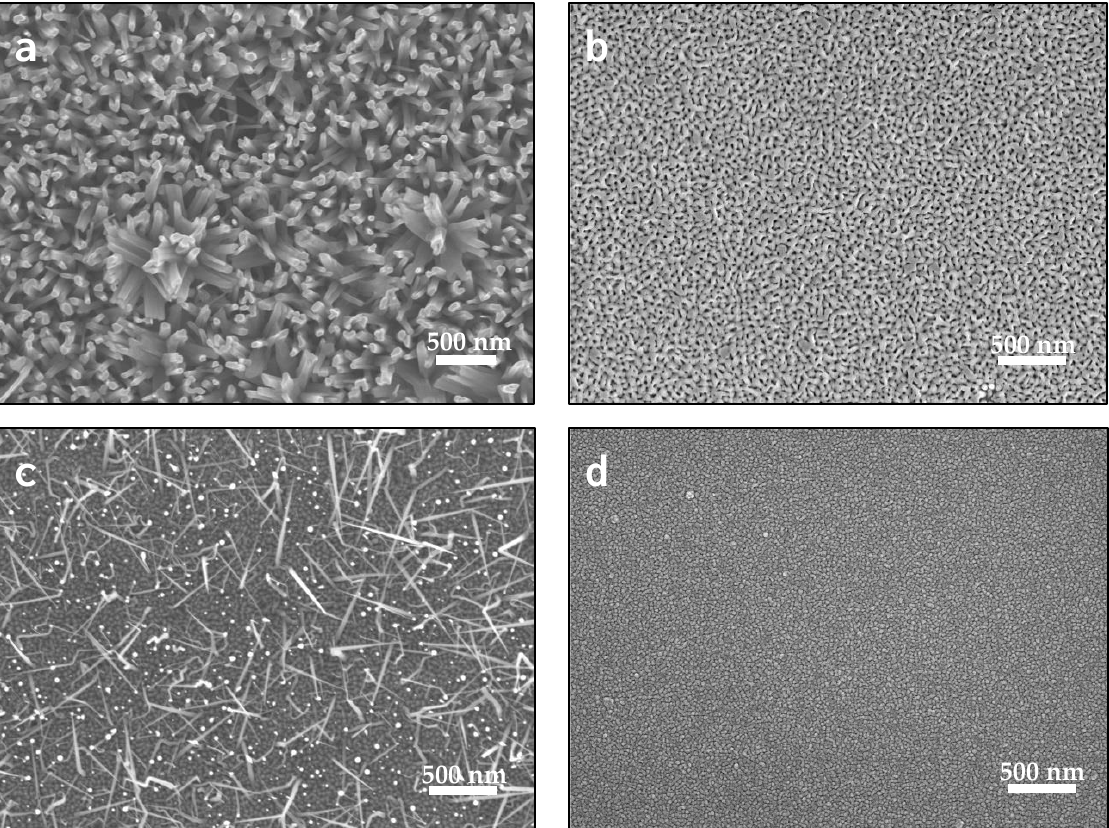
Figure 2. ZnO nanostructures grown by ( a ) PLD at 650 °C under 500 milliTorr (67 Pa) pure O 2 background (nanorods); ( b ) PLD (ZnO target) at 650 °C, under 300 milliTorr (40 Pa) combined Ar + O 2 background (190:8 sccm ratio) (worm-like); ( c ) by PLD (ZnO target) +RFMS (Al 2 O 3 target, 25 W power) at 550 °C, under ~100 milliTorr (~13 Pa) Ar background by template method (nanoneedles); and ( d ) PLD (ZnO target) +RFMS (Al 2 O 3 target, 50 W power) at 550 °C, under 150 milliTorr (~20 Pa) Ar background (heteronanostructures). All scale bars are of 500 nm in length for comparison.